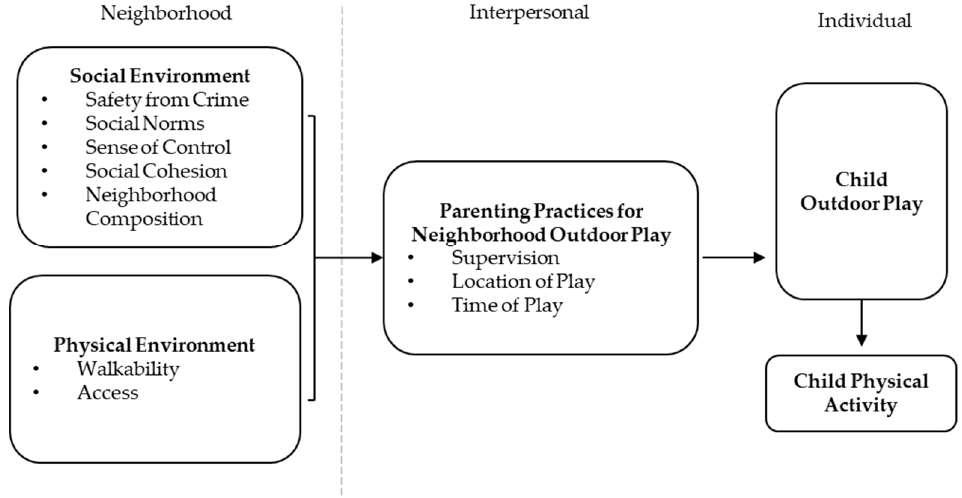
Figure 1. Multilevel influences on children’s outdoor play and physical activity. Table 1. Key di ff erences in perspectives of low- and high-disadvantage